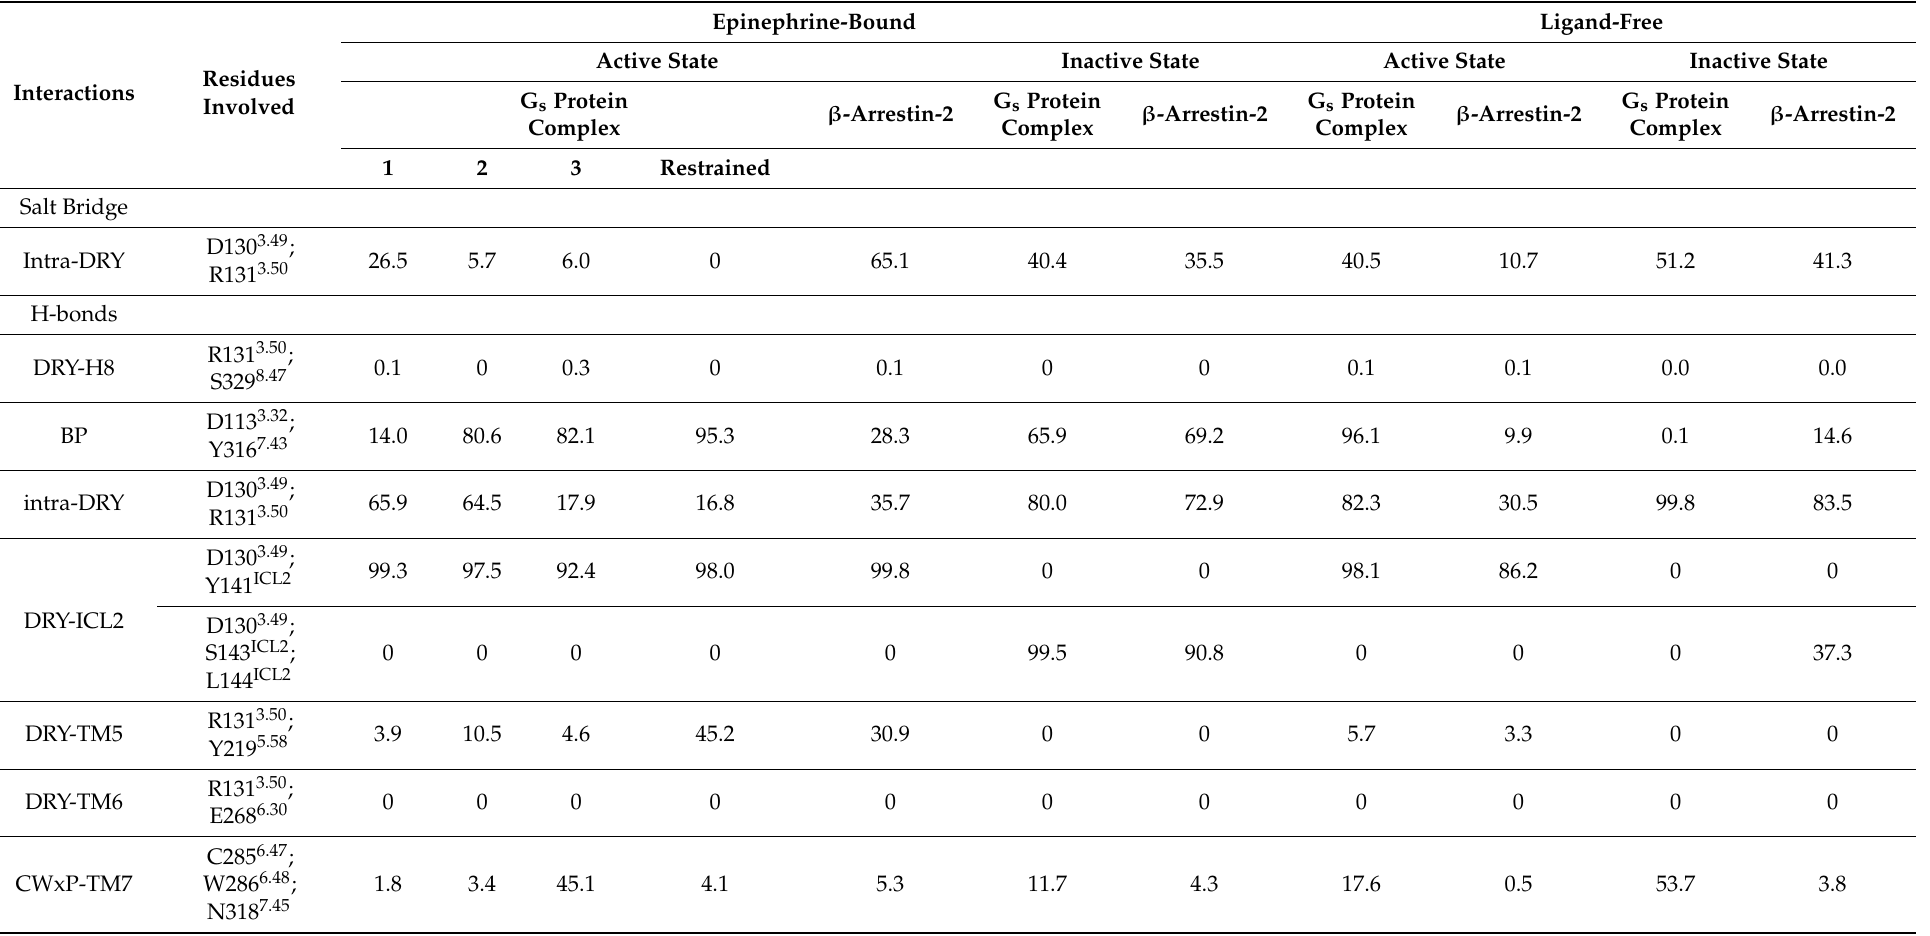
Table 2. Frequency of intramolecular salt bridges and H-bonds expressed as percentages of the total conformational ensemble, generated by MD simulations.